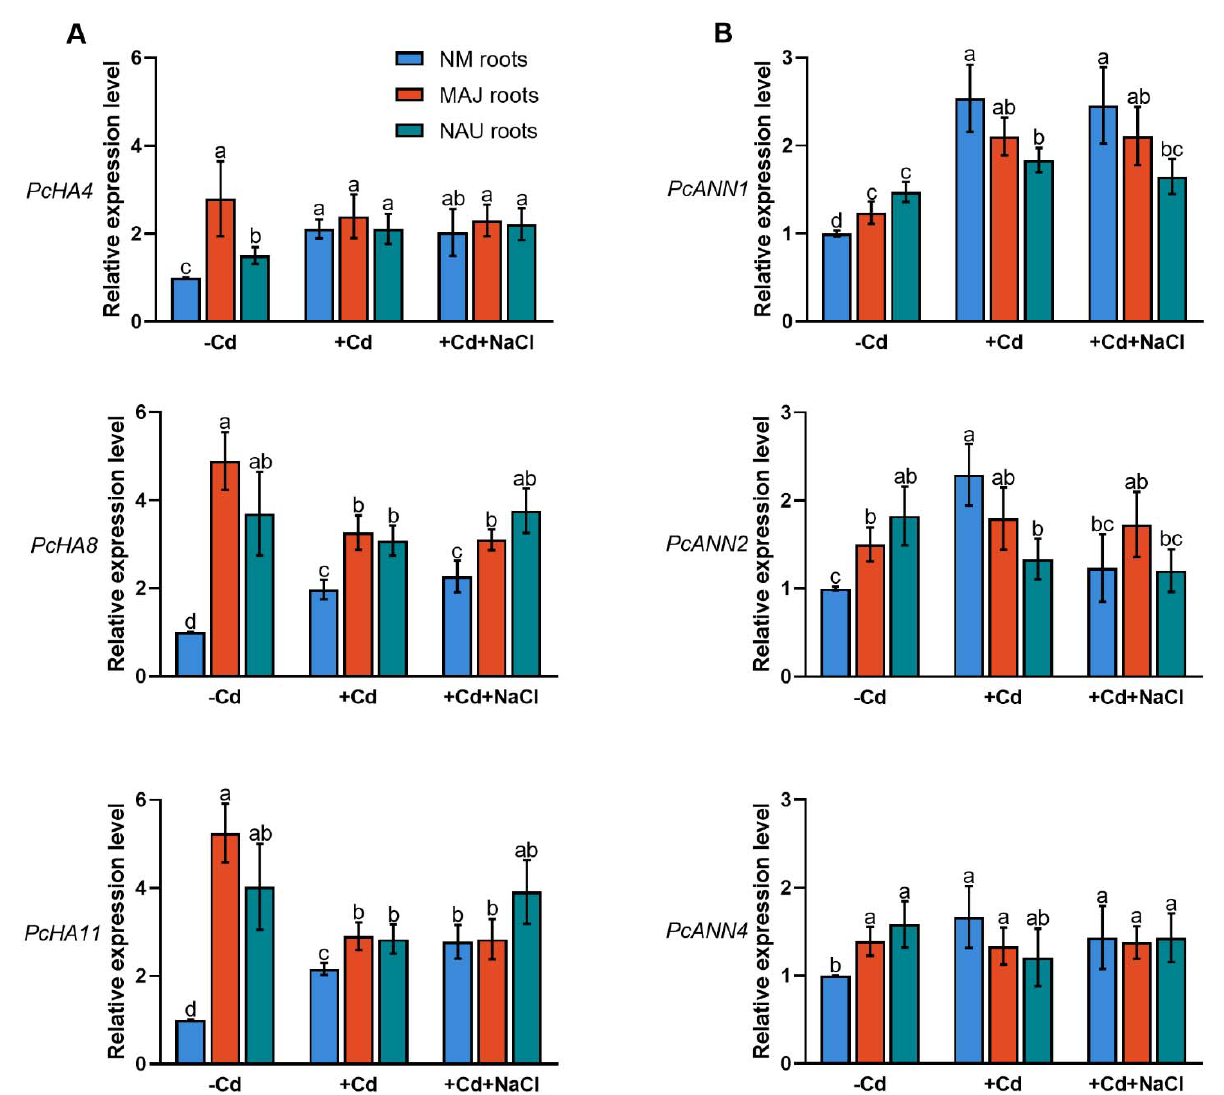
Figure 7. Effects of CdCl 2 as single stress factor or in combination with NaCl on transcriptional profiles of plasmalemma H + -ATPase ( PcHAs ) and annexins ( PcANNs ) in roots of non-mycorrhizal or ectomycorrhizal (EM) Populus × canescens. ( A ) PcHA4 , 8 , 11 . ( B ) PcANN1 , 2 , 4 . Poplar plantlets inoculated with or without Paxillus involutus isolates (MAJ or NAU, 30 d), were hydroponically acclimated and subjected to 24 h of CdCl 2 (0 or 50 µ M) in combination with NaCl (0 or 100 mM). Roots were harvested from EM- and NM-poplars and used for total RNA isolation and RT-qPCR. 18S rRNA was used as a reference gene. Specific primers designed to target PcHA4, 8, 11 , PcANN1, 2, 4 and 18S rRNA are shown in Table S1. Mean values of PcHAs and PcANNs relative transcript levels in control ( − Cd), CdCl 2 stress (+Cd), and combined CdCl 2 and NaCl stress (+Cd + NaCl) are shown. Each column is mean ± SD obtained from 3 independent experiments. Statistically significant differences ( p < 0.05) among treatments are indicated with different letters (a–d).